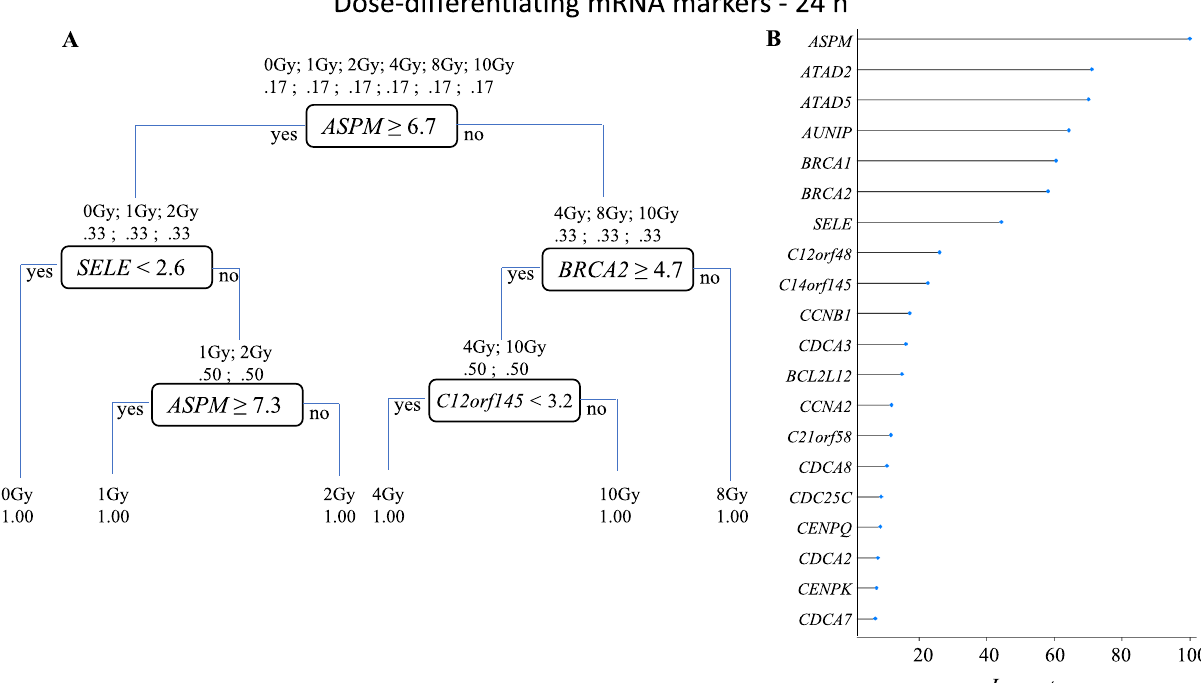
Figure 4. Dose-differentiation mRNA markers at 24 h. ( A ) Decision tree based on the RPART analysis performed in R for dose differentiation at 24 h based on the 93 mRNAs at the intersection of all doses in supplementary Fig. 2A. A combination of five mRNAs could differentiate all dose classes. Each node represents an mRNA intensity value based on which a decision is made, and classes are sorted. At the starting node there is a 17% chance of a sample falling into any of the six classes (0 Gy, 1 Gy, 2 Gy, 4 Gy, 8 Gy, 10 Gy). Decision at the first node divides the samples into two groups (0 Gy, 1 Gy, 2 Gy) and (4 Gy, 8 Gy, 10 Gy) at the second step. Two different mRNAs’ intensity values are used to divide the classes further. This process is repeated till all the classes are separated. ( B ) Plot shows relative importance of different mRNAs in dose-separation shown in ( A